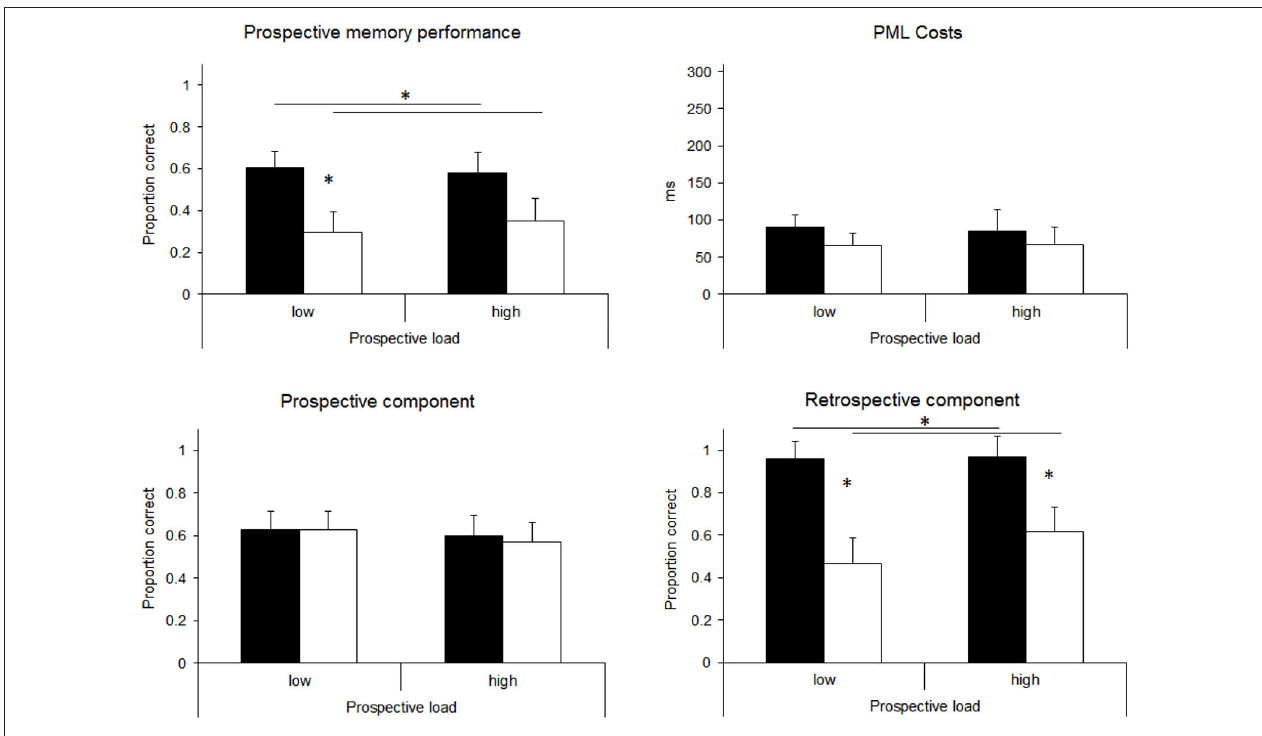
(pressing the correct response) . Black bars represent the low retrospective load (RL) condition, white bars the high RL conditions. Significant differences ( p < 0.05) are indicated by asterisks. Error bars represent standard